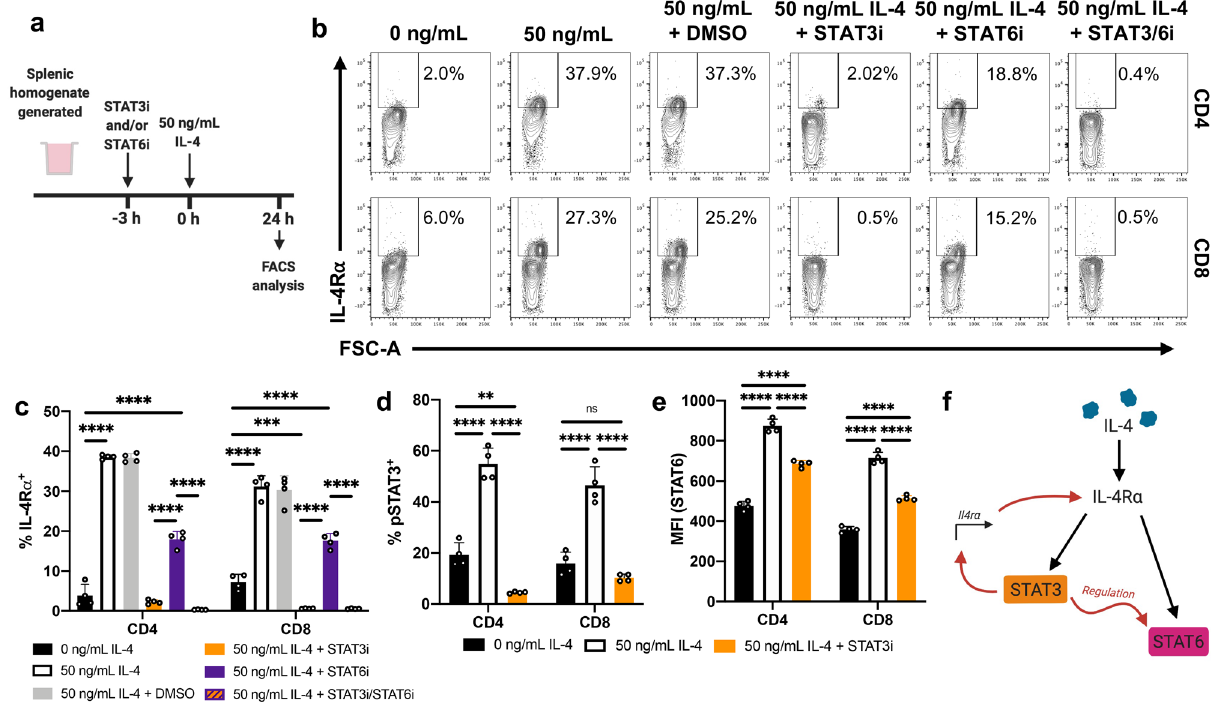
Figure 5. STAT3 regulates IL-4R ⍺ expression to affect downstream STAT6 activation. (a) Whole spleen homogenate derived from naïve 6–8-week-old female BALB/c mice ( n = 4) were pre-incubated with STAT3i and/or STAT6i in vitro for 3 h prior to stimulation with 50 ng/mL IL-4 for 24 h prior to flow cytometric analysis. (b) The percentage of CD4 and CD8 T cells found to be IL-4R ⍺ + for each inhibitory/stimulatory group. (c) Representative contour plots showing the expression of IL-4R ⍺ . (d) Cells were pre-incubated with STAT3i prior to 24 h IL-4 stimulation. Phosphorylation statuses were subsequently evaluated. The percentage of T cells found to be pSTAT3 + . (e) pSTAT6 MFI for each treatment group. Representative plots shown in Sup Fig. 5e–f. (f) Graphical and temporal depiction of the proposed regulatory relationship between STAT3 and STAT6––created using BioRender. Data are represented as mean + SD, where dots represent biological replicates from a single experiment. The experiments were repeated at least twice. Two-way ANOVA combined with Tukey’s post- hoc multiple comparison test was conducted to compare groups. p -value denotations: ‘ns’ p ≥ 0.05, ‘**’ p < 0.01, ‘***’ p < 0.001 and ‘****’ p <